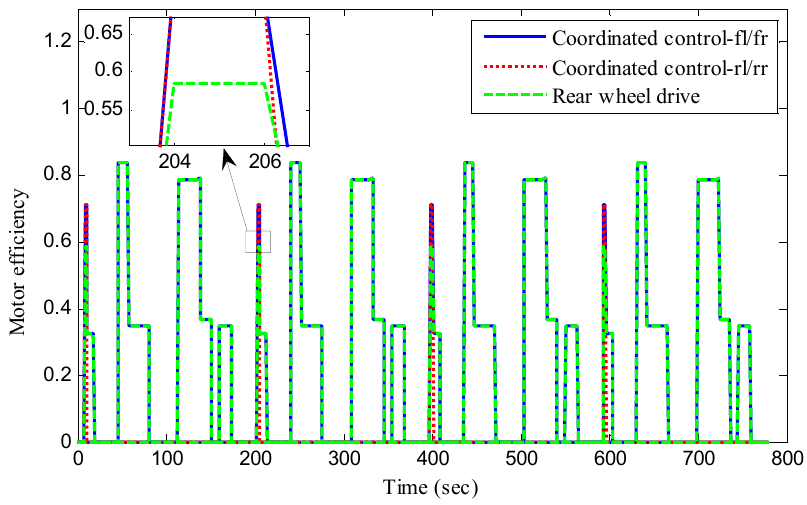
Figure 21. Torque distribution results in case study 3.